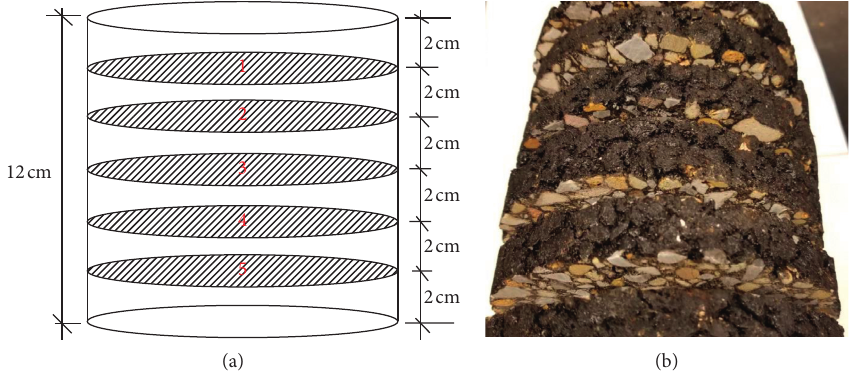
Figure 2: Preparation of sample